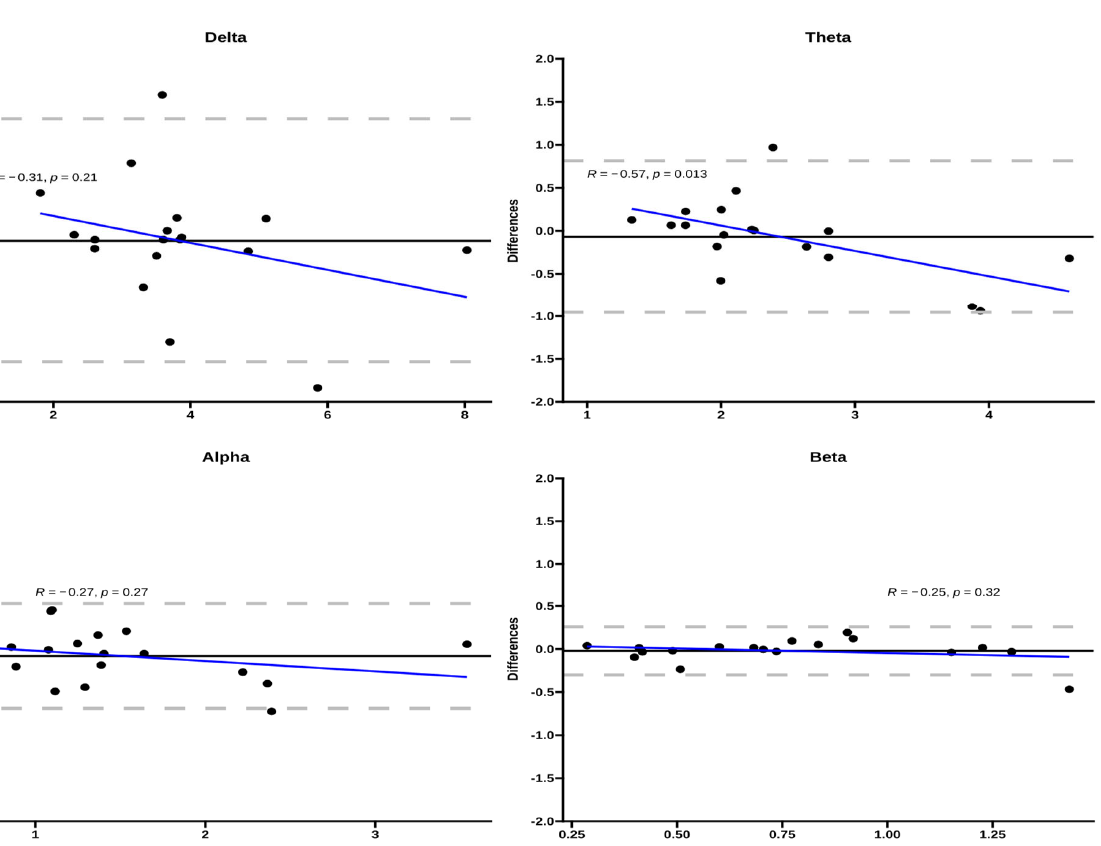
Figure 2. Scale map representation showing the differences between evaluation 1 (first line) and evaluation 2 (second line) for the 12 RM condition.